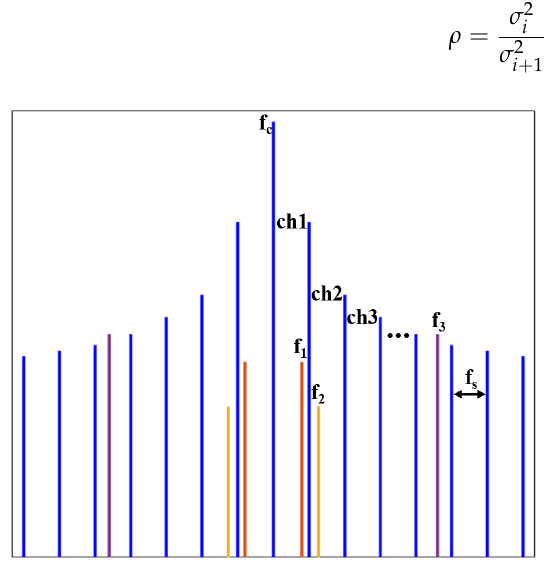
Figure 5. Spectrum diagram after a 45-degree